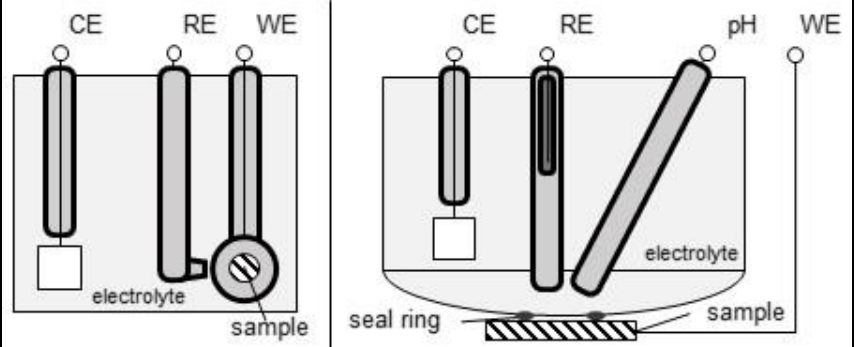
Figure 1. Schematic set-ups of the electrochemical measurements without ( left ) and with a pH electrode ( right ).